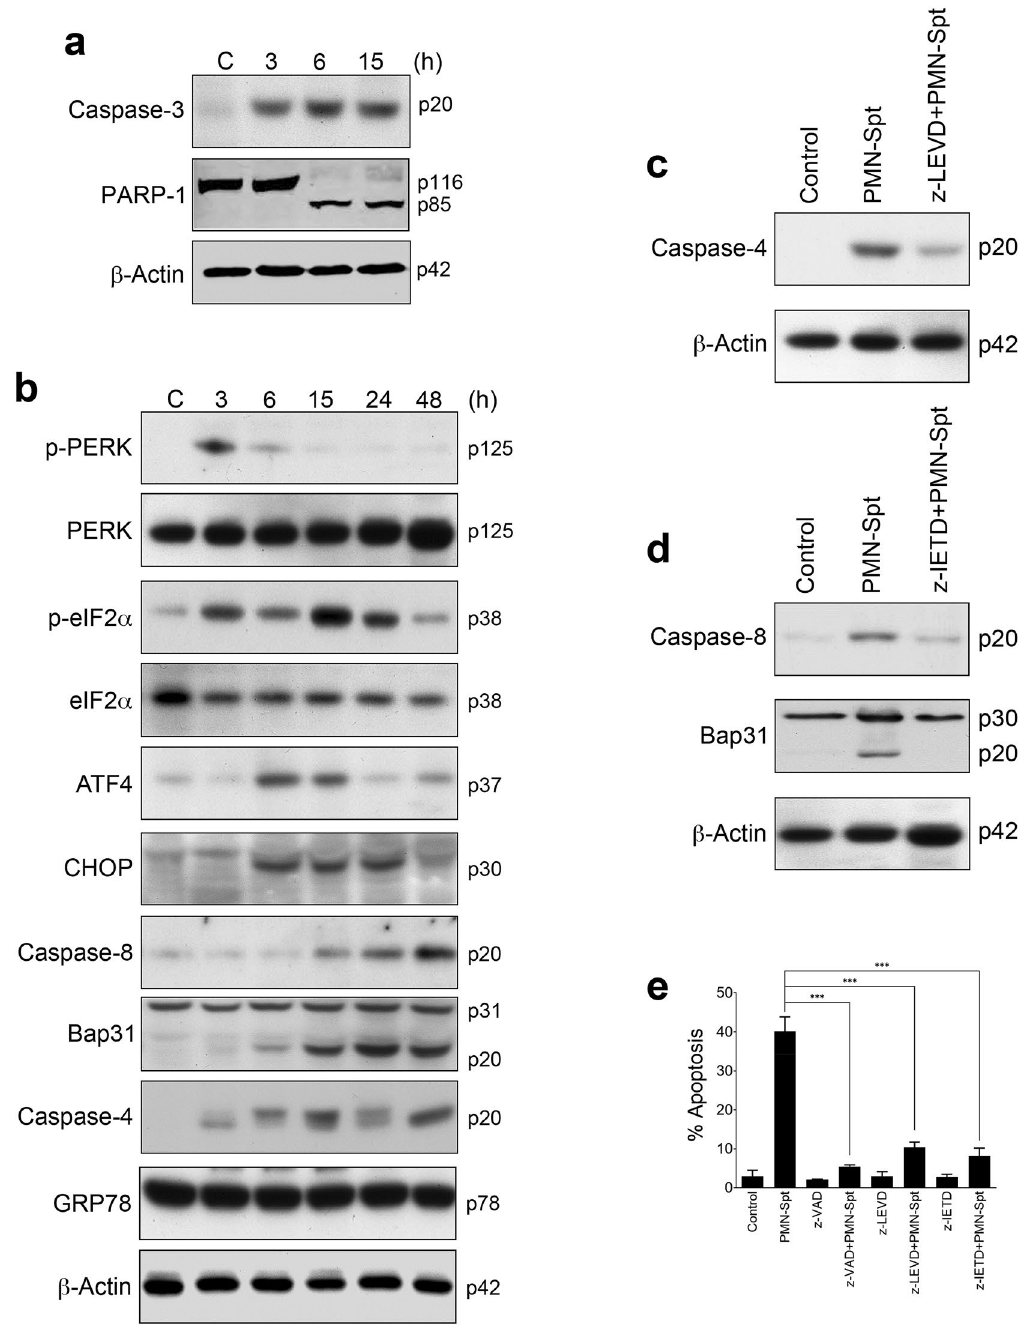
Figure 5. Conditioned media from activated neutrophils induce apoptosis in Bx-PC-3 pancreatic tumor cells by activation of ER stress signals. ( a , b ) 1.5 × 10 7 neutrophils were stimulated with 100 nM fMLP, and the supernatant was incubated with the BxPC-3 cell line for the indicated times. Then, protein extracts were prepared and analyzed by Western blot. ( c , d ) Supernatants from fMLP-stimulated neutrophils (PMN-Spt) were incubated with BxPC-3 pancreatic cancer cells for 24 h, which were previously untreated or pretreated for 1 h with 20 μM z-LEVD-fmk (caspase-4 inhibitor) or 100 μM z-IETD-fmk (caspase-8 inhibitor), and then analyzed for caspase-4 activation ( c ), or caspase-8 activation and Bap31 cleavage ( d ). β-Actin was used as loading control. Molecular weights (in kilodaltons) of each protein are indicated at the right side of each panel. The results shown in ( a – d ) are representative of three independent experiments. The gels were cropped to show the relevant sections. ( e ) Induction of apoptosis determined by Annexin-V staining following incubation of BxPC-3 cells with PMN-Spt for 24 h, in the absence or presence of z-VAD, z-LEVD or z-IETD (FlowJo X 10.0.7r2— proprietary commercial software—https:// www. flowjo. com/). The data correspond to the mean ± SD of at least three independent experiments. Asterisks indicate significant differences. *** P < 0.001. (GraphPad Prism 8.0.1— proprietary commercial software—https:// www. graph pad.